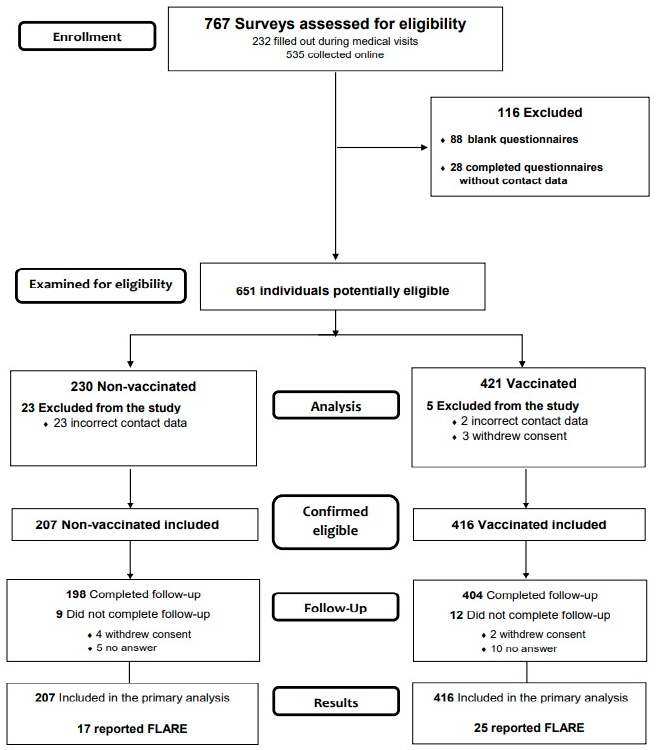
Figure 1. The flow diagram of the study describing the methods: participant’s recruitment, inclusions, exclusions and follow ‐ up.